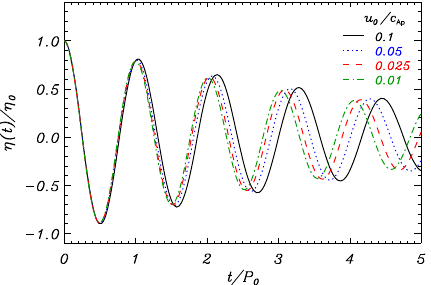
Fig. 82 Prominence thread transverse displacement as a function of time (in units of the instantaneous period at t = 0, P 0 ), for various values of the flow velocity, u 0 / c Ap , with c Ap = v Ap the thread Alfvén speed. In all computations the transverse inhomogeneity length-scale is l / a = 0 . 1, the density contrast is ρ p /ρ c = 200, and the length of the thread is 0.1 times the full length of the flux tube, L . Image reproduced with permission from Soler et al. (2012), copyright by